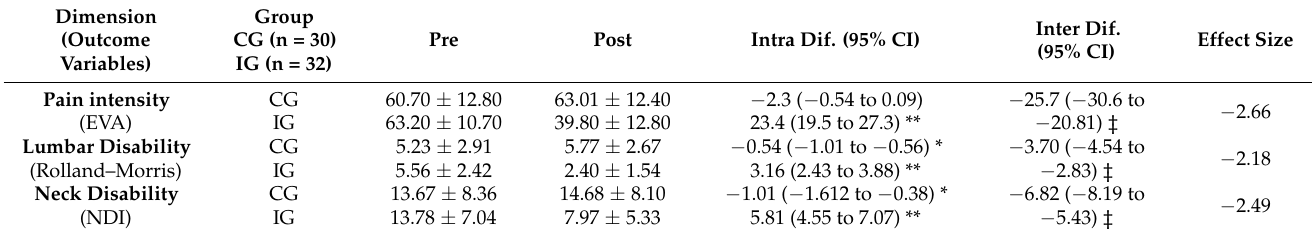
Table 5. Results (mean ± standard deviation) of the effect of the intervention on the intensity of pain and lower back and cervical